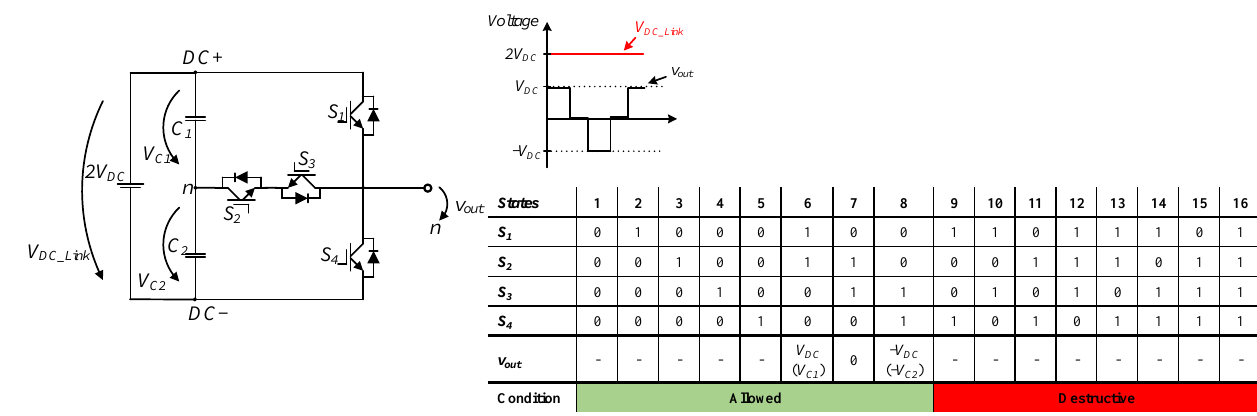
11 of 54 Figure 7. Submodule NPC topology for cascaded applications and operation principle. A cascaded MLC based on NPC cells was presented by M. Carpanet et. al. in [102]. A novel hybrid MLC based on NPC cells cascaded with half-bridge chopper cells for three phase applications was presented in [103]. An SST solution composed by a multilevel DAB converter was proposed in [104], where a three-level NPC was adopted to be used on the high-voltage side.